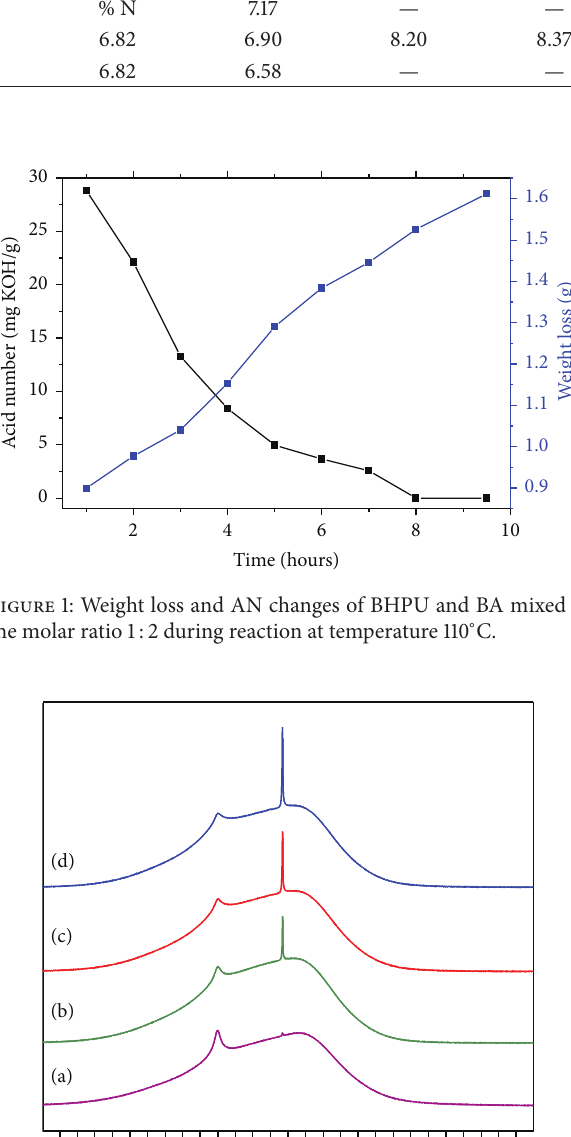
Table 1: Elemental analysis of the reaction mixture obtained at initial molar ratio of BHPU :BA 1:2 at temperature 110 ∘ C. Time (h)